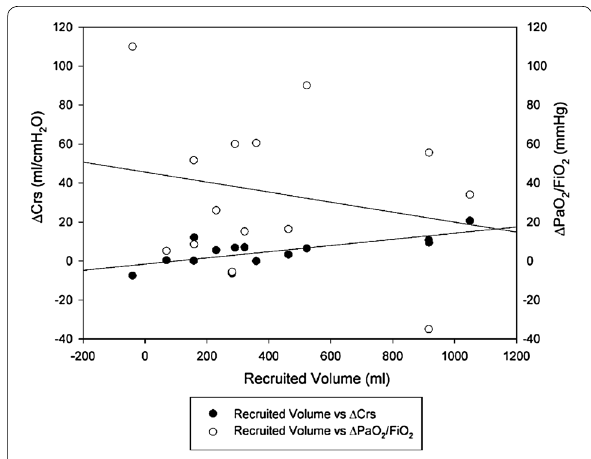
Fig. 5 Correlations between recruited volume, compliance and oxygenation. The amount of recruited volume did not correlate with oxygenation improvement ( R 2 correlated with the improvement in respiratory system compliance ( R 2 0.50, p < =